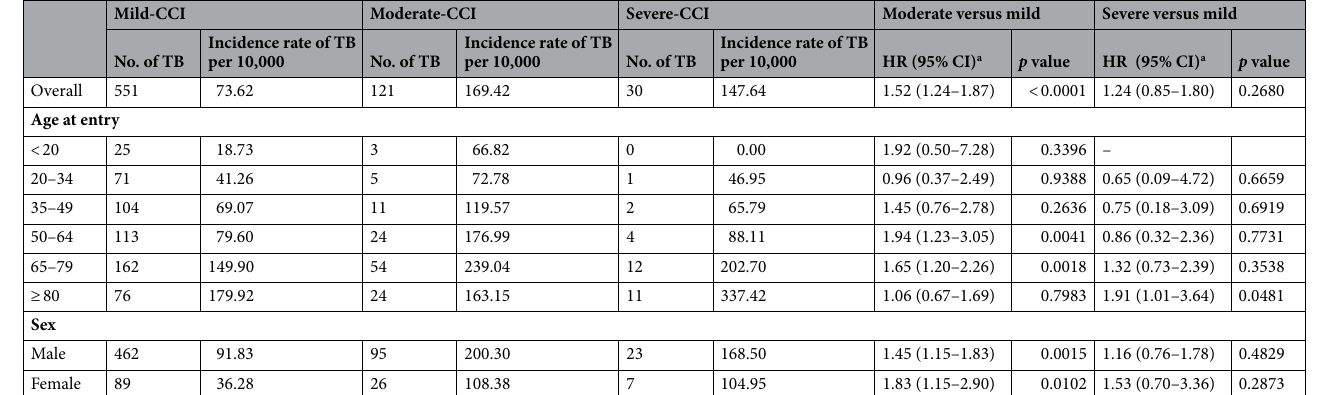
Table 4. Tuberculosis incidence and relative risk among TBI patients with different Charlson’s Comorbidity Index groups. CCI Charlson’s comorbidity index, TB tuberculosis, HR hazard ratio, CI confidence interval. a Adjusted by the variables of age, gender, the length of stay, and the length of ICU stays, but excluding the stratified variable in the model.